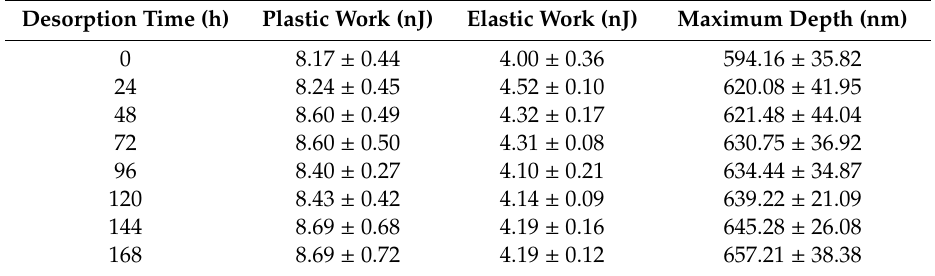
Figure 14. Hardness and reduced Young’s modulus of the specimen charged at 320 mA / cm 2 and after left at room temperature for hydrogen desorption. The means and standard deviations based on ten independent measurements are shown. Table 3. Nanoindentation properties measured at different hydrogen desorption times for the specimen charged at 320 mA/cm 2.